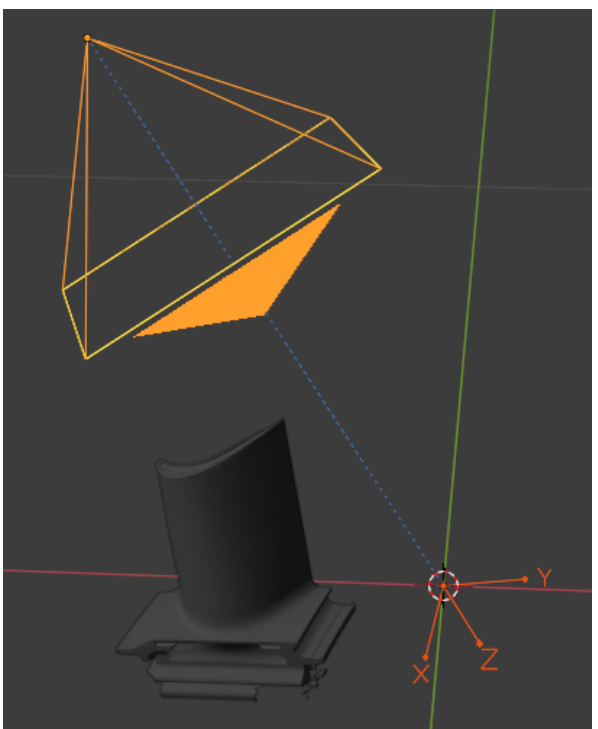
Figure 3. The camera is constrained to look at an invisible object (X, Y, Z) at the scenes origin. By moving the 3D model and rotating the camera through the empty object we change the pose of our 3D model in the rendered